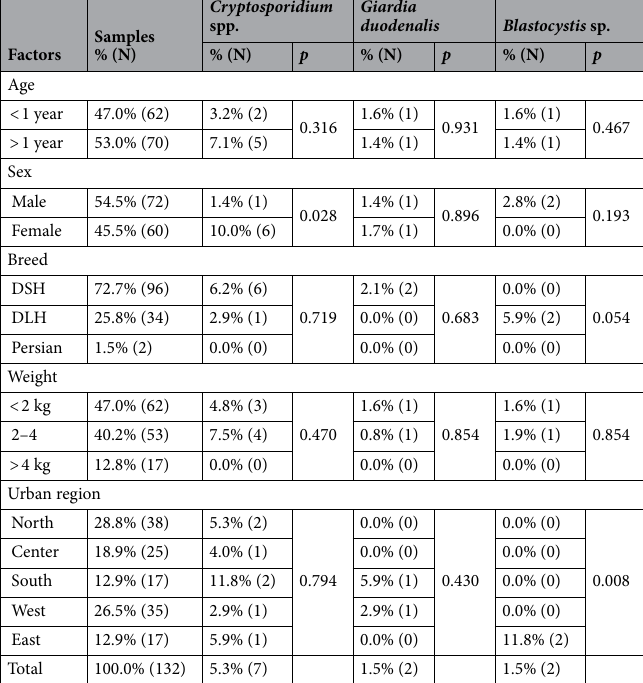
Table 2. The demographics and the prevalence of Cryptosporidium spp., Giardia duodenalis , and Blastocystis sp. in the stray cats of Tehran, Iran.